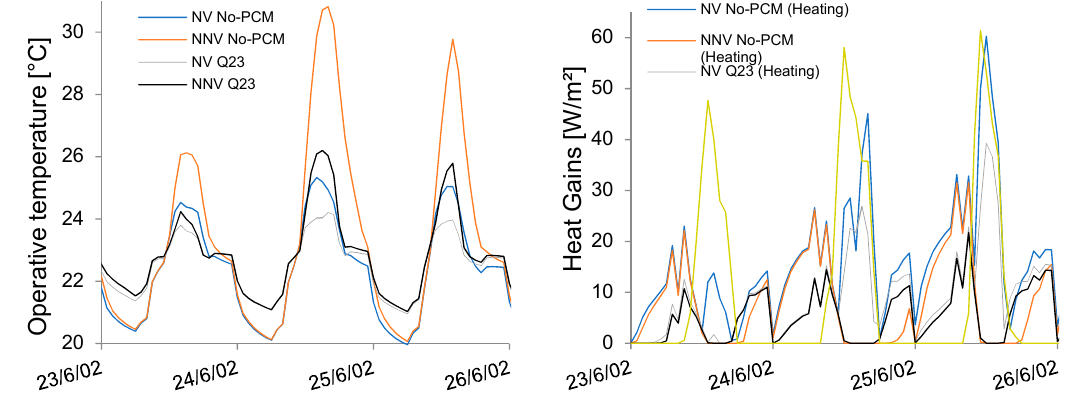
Figure 12. Operative temperature ( left ) and heat gains ( right ) for winter days 23–25 June (building B, Seq. 4).